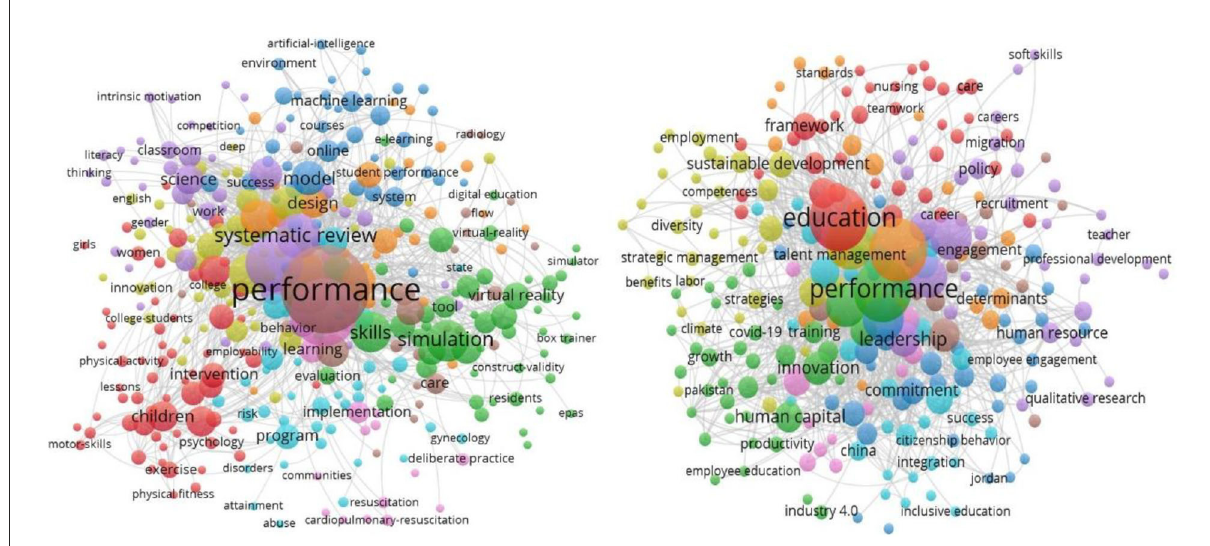
FIGURE1 The dimension of the research in the field of education and human